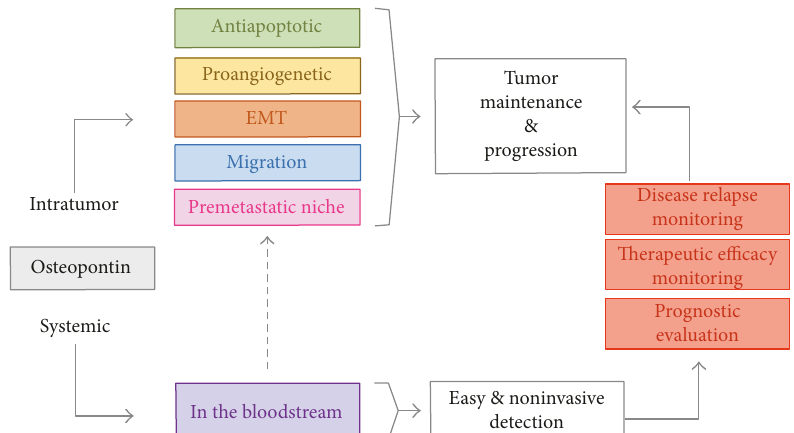
Figure 3: Schematic representation of the role of OPN in tumor patients. OPN is involved in many di ff erent biological functions as well as in tumor maintenance and progression. Besides its local e ff ect, OPN is also secreted in the blood stream, and its levels are increased in patients with di ff erent tumor types. Since measurement of OPN from plasma or serum is readily accessible and noninvasive, it is likely that OPN might become a useful marker for the diagnosis, treatment, and tumor relapse monitoring of a number of